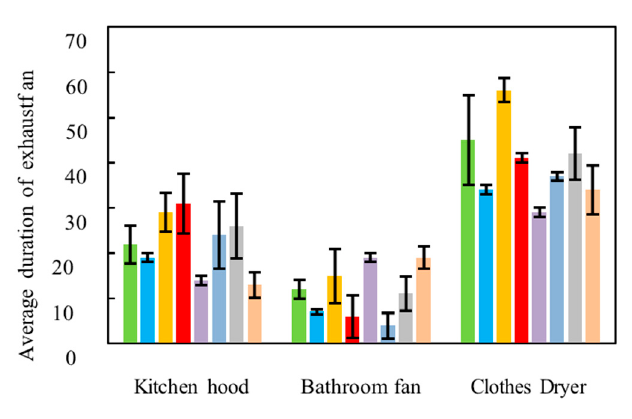
Figure 2. Average duration of an exhaust fan activation event across the eight monitored